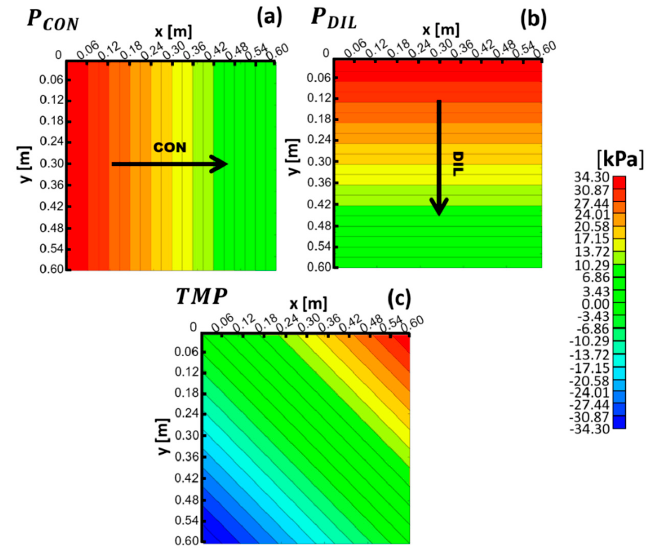
Figure 11. Results for a cross flow stack of 0.6 m sides at P in − P out = 34.3 kPa ( U s = 10 cm / s) in the absence of membrane deformation: relative pressure maps for the CON ( a ) and DIL ( b ) channels, and TMP ( c ). Energies 2019 , 12 , x FOR PEER REVIEW